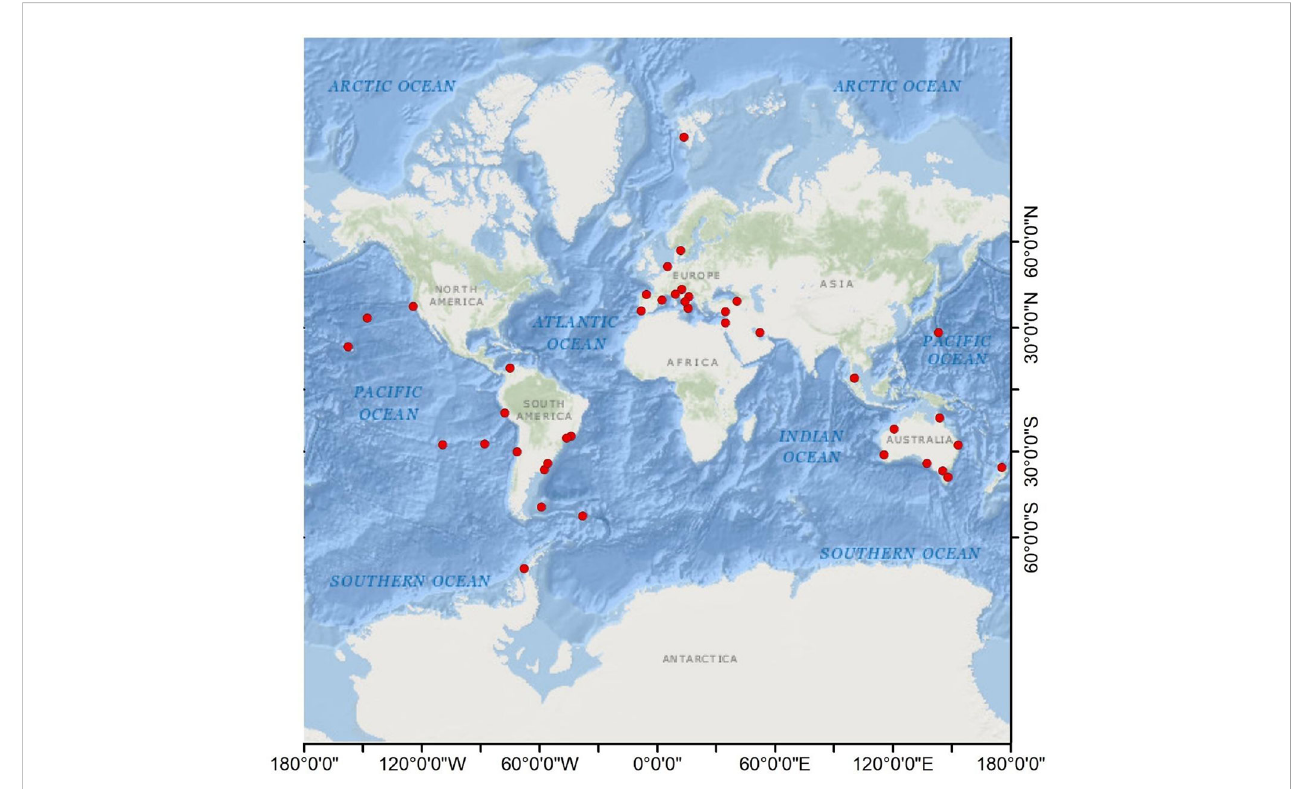
FIGURE 2 Geographic map indicating the marine litter colonization studies (red dots). The map was constructed using ArcGIS (version